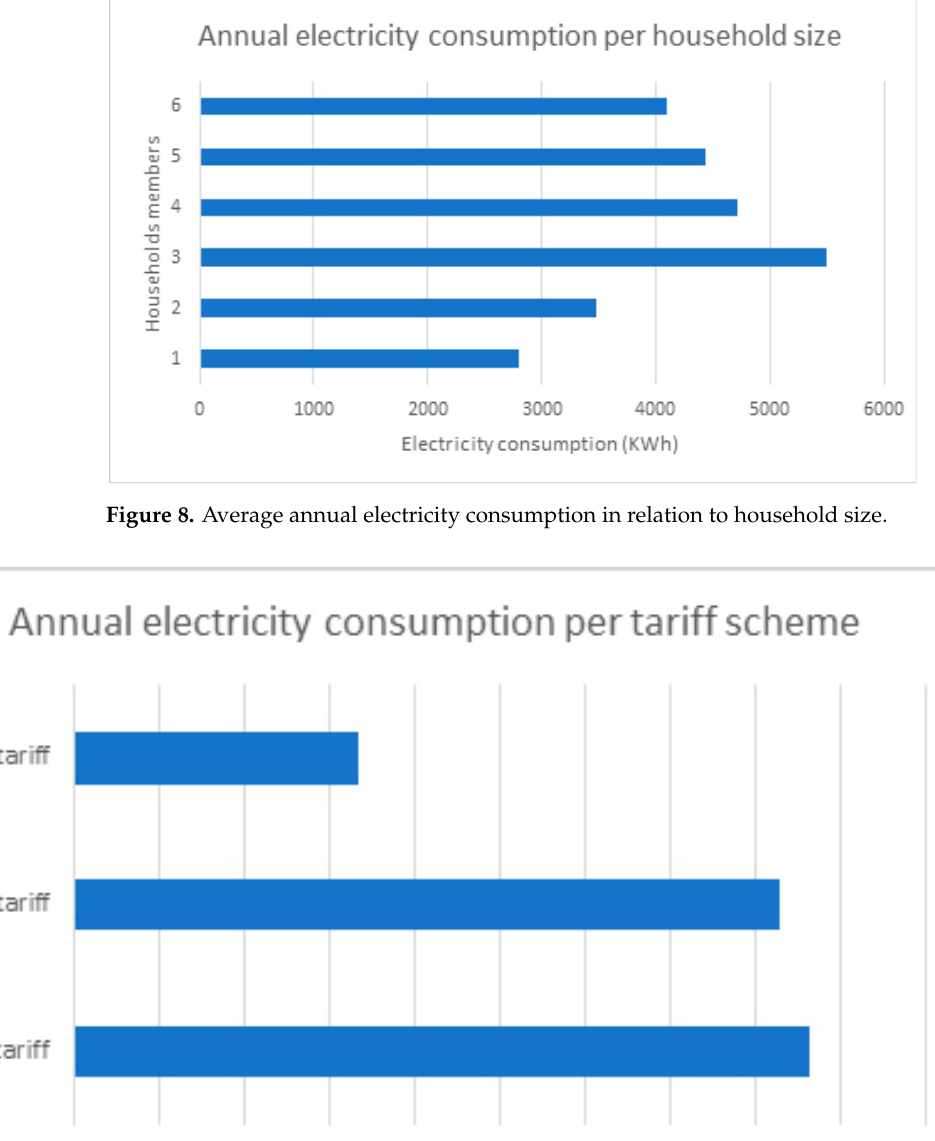
Figure 9. Average annual electricity consumption by tariff scheme.